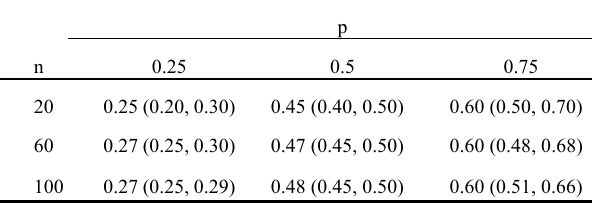
Table 2 . Median and interquartile range of the proportion of pat- terns classified as top-to-bottom.